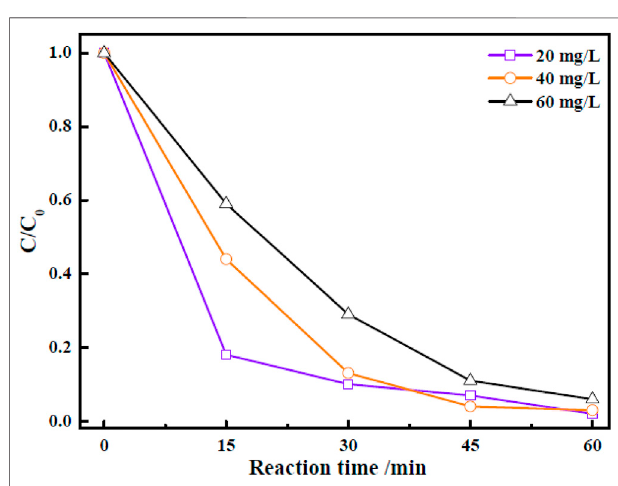
FIGURE7| EffectofdifferentconcentrationsofRhBonitsphotocatalytic degradation under visible light